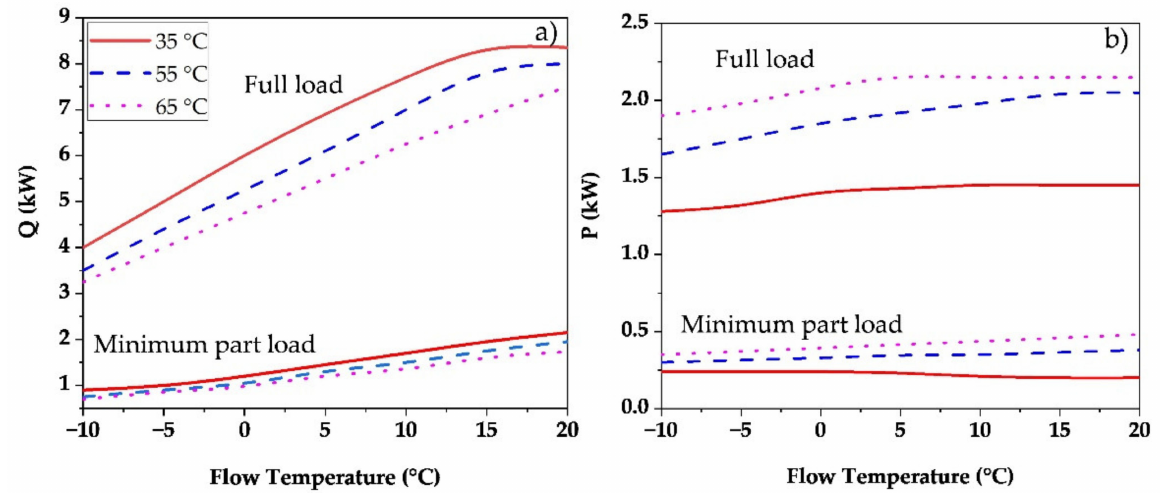
Figure 1. Characteristic curves of the used heat pump for heating power ( a ) and electrical consump- tion ( b ) according to flow temperature, own representation according to [20].